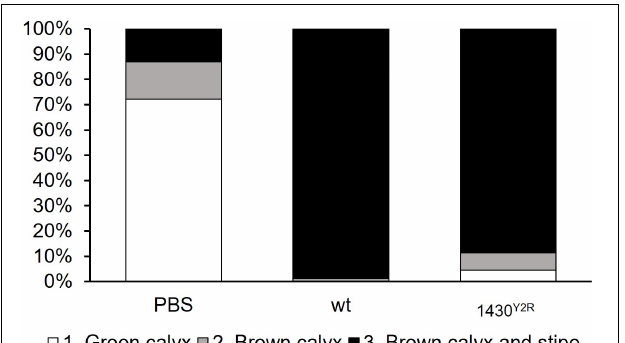
FIGURE 3 | Virulence of 1430 Y 2 R in detached apple blossoms. Two-year-old Golden Delicious blossoms were infected with 10 7 CFU/ml bacteria and incubated for 4 days. Read out was performed by evaluating disease symptoms. Grade 1 (green calyx, white boxes) indicates healthy blossoms without disease symptoms. Grade 2 (grey boxes) refers to blossoms with first disease symptoms such as browning of the calix. Blossoms showing advanced disease symptoms on both calyx and stipe correspond to Grade 3 (black boxes). Each treatment was tested at least on 60 individual blossoms. PBS, phosphate buffered saline; wt, wild type. The experiment was performed three